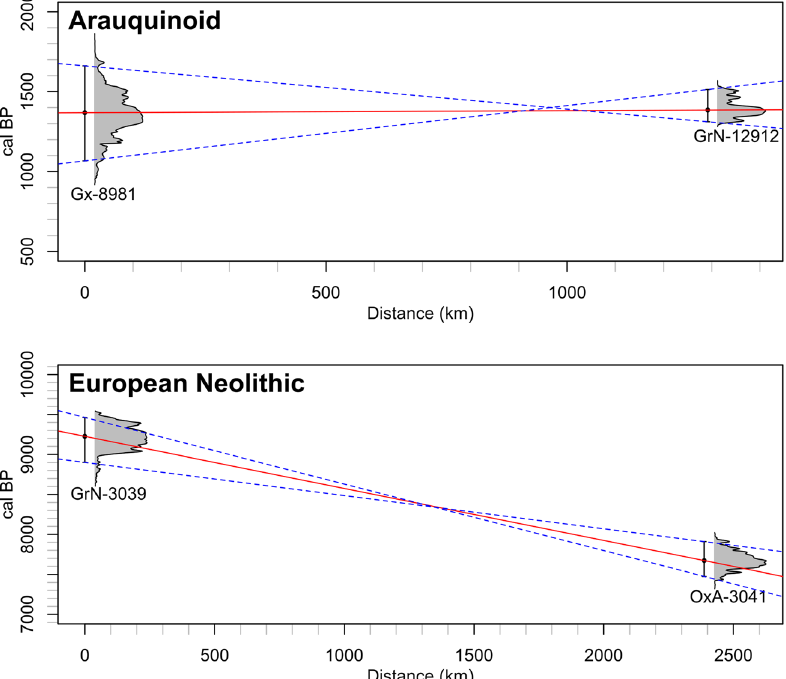
Fig. 2 Example of two radiocarbon dates in each dataset that are among the earliest at opposite ends of the dispersal domain. Top: Middle Orinoco and Suriname for the Arauquinoid dispersal. Bottom: Greece and Great Britain for the European Neolithic. Shown are the median dates (dot), 95% calibrated range (error bars) and full calibrated distributions (grey-shaded), as well as the results of linear regressions using the median dates (solid red line) and the cross ends of the 95% ranges (dashed blue